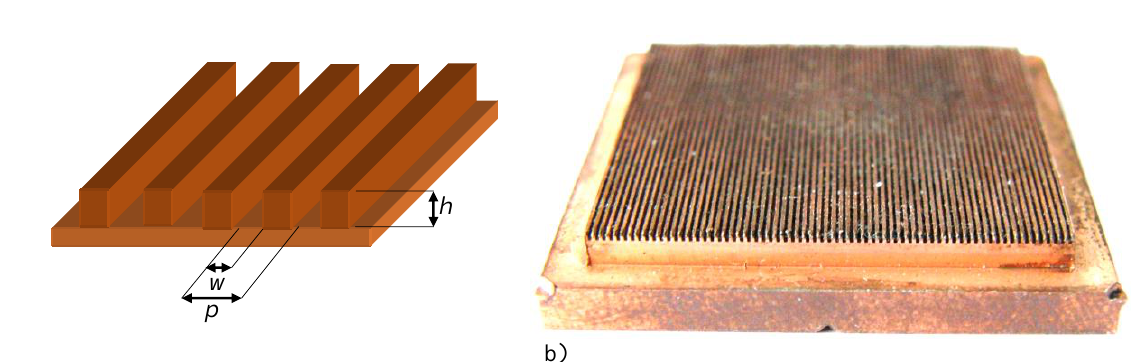
Fig. 1. Pool boiling measurement stand.